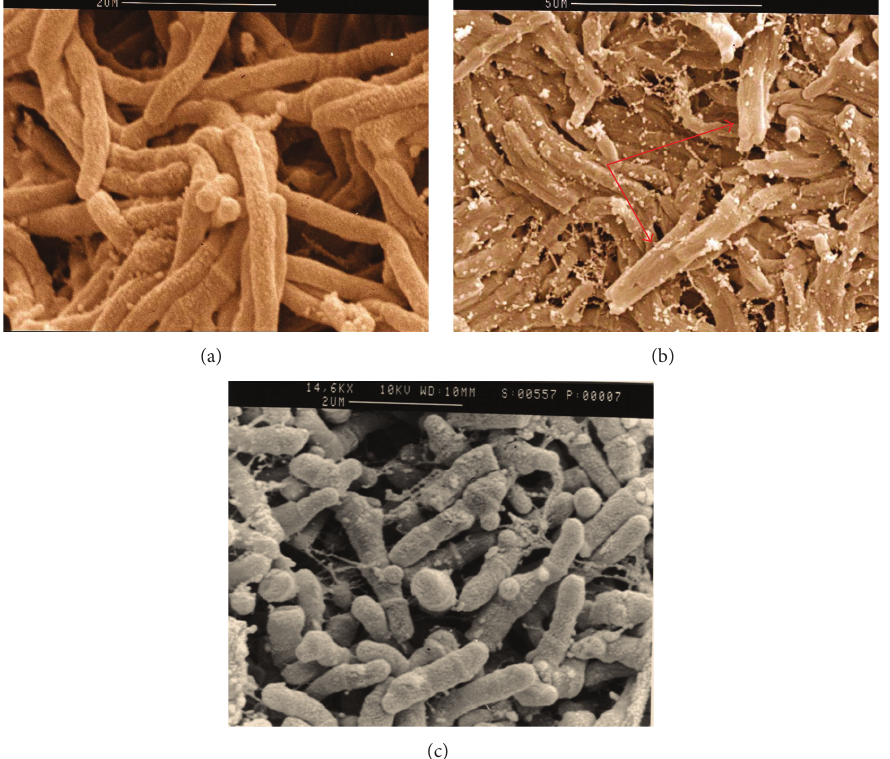
Figure 4: Scanning electron microscopy of M. farcinogenes (a), M. senegalense (b), and Nocardia farcinica (c) . Note the true-nonfragmenting branched filaments in both species and the presence of “synnemata” in M. senegalense